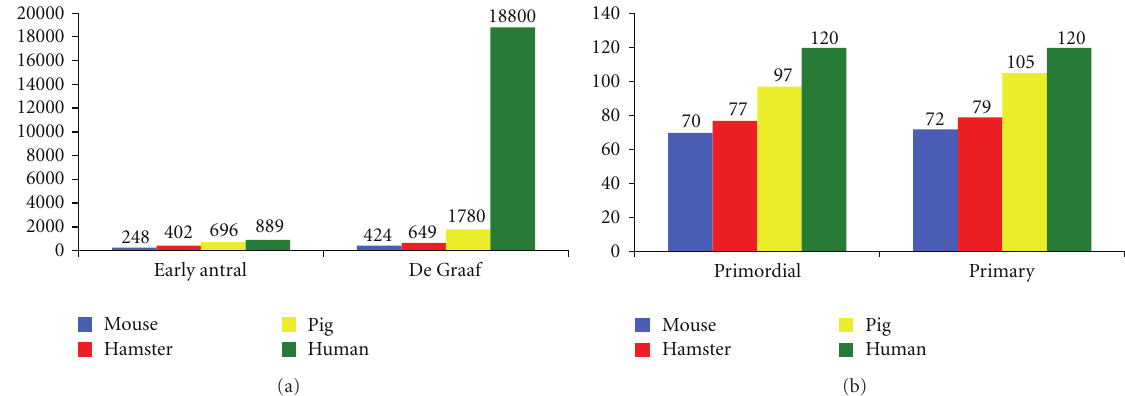
Figure 5: See [6, 10]. (a) Diameters of early antral follicles, and Graafian follicles of 4 species. (b) Oocyte diameters of early antral follicles and Graafian follicles of 4 species.